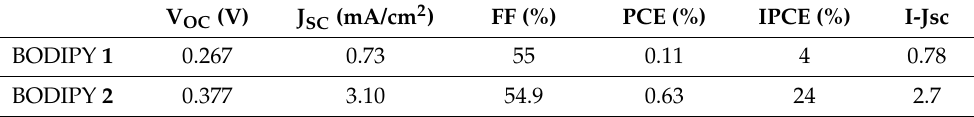
Table 3. Photovoltaic performances of the best-realized device for BODIPY 1 and BPDIPY 2 . V OC